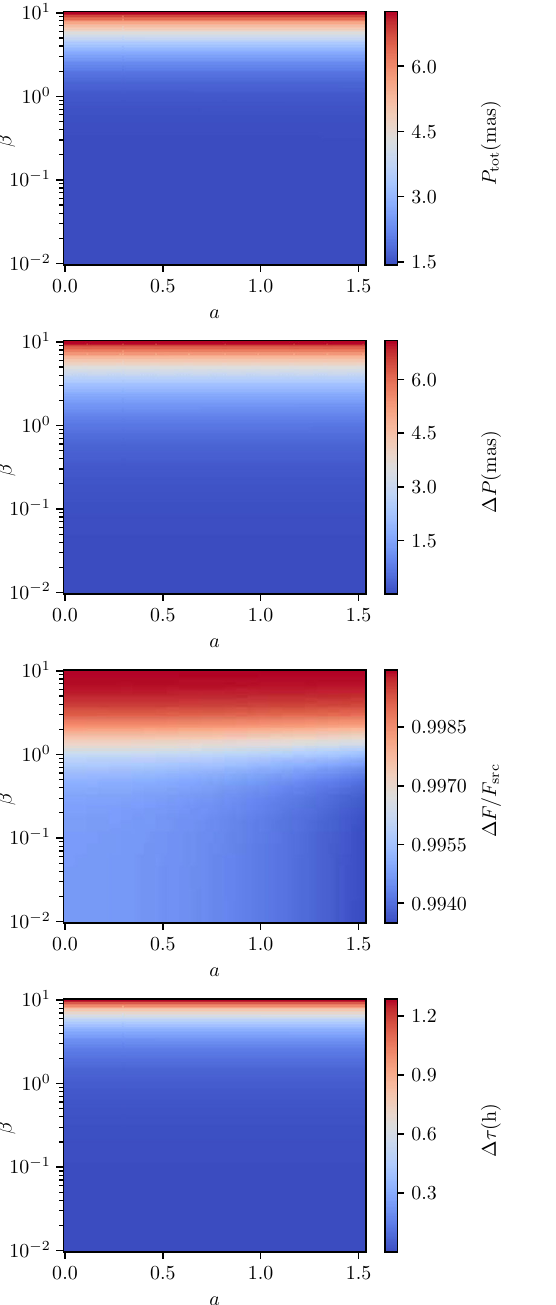
0 . 5 µ mag, | δ S cent , AS | < 0 . 3 nas and | δ(cid:15)τ AS | ∼ O (ε 4 )